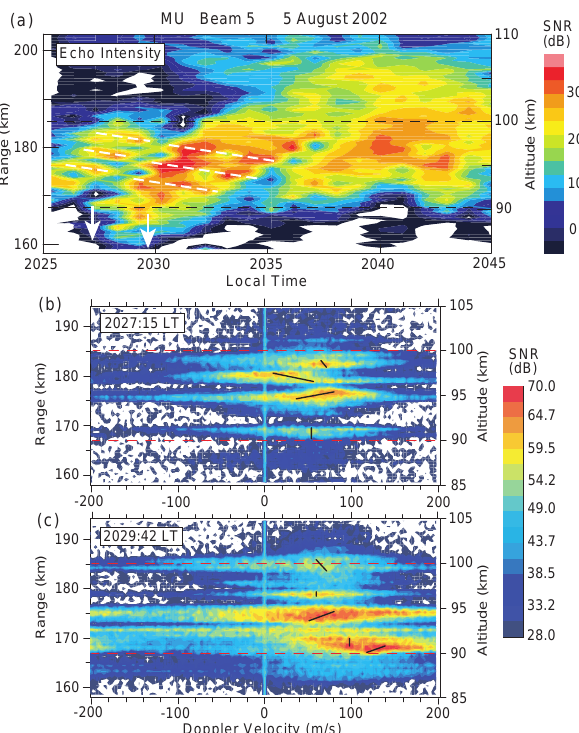
Fig. 8. (a) Range-time-intensity plot of MU radar echoes on beam 5. Range variation of Doppler spectrum at time indicated by an arrow in (a): (b) 20:27:15 LT and (c) 20:29:42 LT. Plus (minus) sign of Doppler velocity represents motion away from (toward) the radar. Solid lines in (b) and (c) connect the peak position of each spectrum .